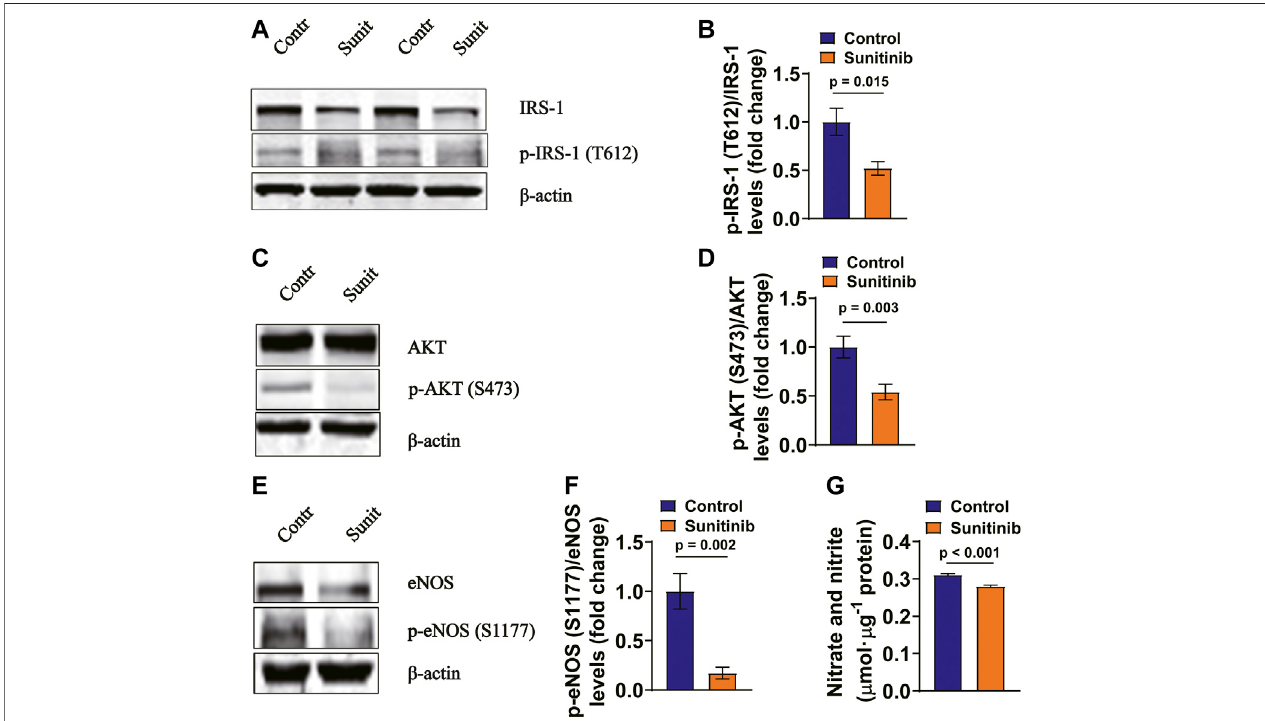
FIGURE 5 | Sunitinib inhibits insulin signaling associated molecules in rat MAECs (A) Representative western blots of total IRS-1 and phospho-Tyr612 IRS-1 in controlMAECsorinMAECstreatedwith1 μ Msunitinibfor30 minandbargraphrepresentsphospho-Tyr612IRS-1levelsnormalizedtototalIRS-1levels. (B) ( p (cid:2) 0.015 vs. control; n (cid:2) 6batches ofcells in each group). (C) Representative western blot images oftotal AKT and phospho-Ser473 AKT expression in control MAECs cells or in MAECstreatedwith1 μ Msunitinibfor30 minandbargraphrepresentsphospho-Ser473AKTlevelsnormalizedtototalAKTlevels. (D) ( p (cid:2) 0.003vs.control; n (cid:2) 7 batches of cells in each group). (E) Representative western blot images of total eNOS and phospho-Ser1177 eNOS expression in control MAECs cell or in MAECs treatedwith1 μ Msunitinib for30 minand bargraphrepresentsphospho-Ser1177eNOS levelsnormalizedtototaleNOS levels. (F) ( p (cid:2) 0.002vs.control, n (cid:2) 7batches ofcellsineachgroup). (G) TheconcentrationsofnitrateandnitritemeasuredinthecontrolMAECscellsorinMAECstreatedwith1 μ Msunitinibfor30 min,re fl ectingNO production under indicated experimental condition ( p < 0.001 vs. control; n (cid:2) 6 per